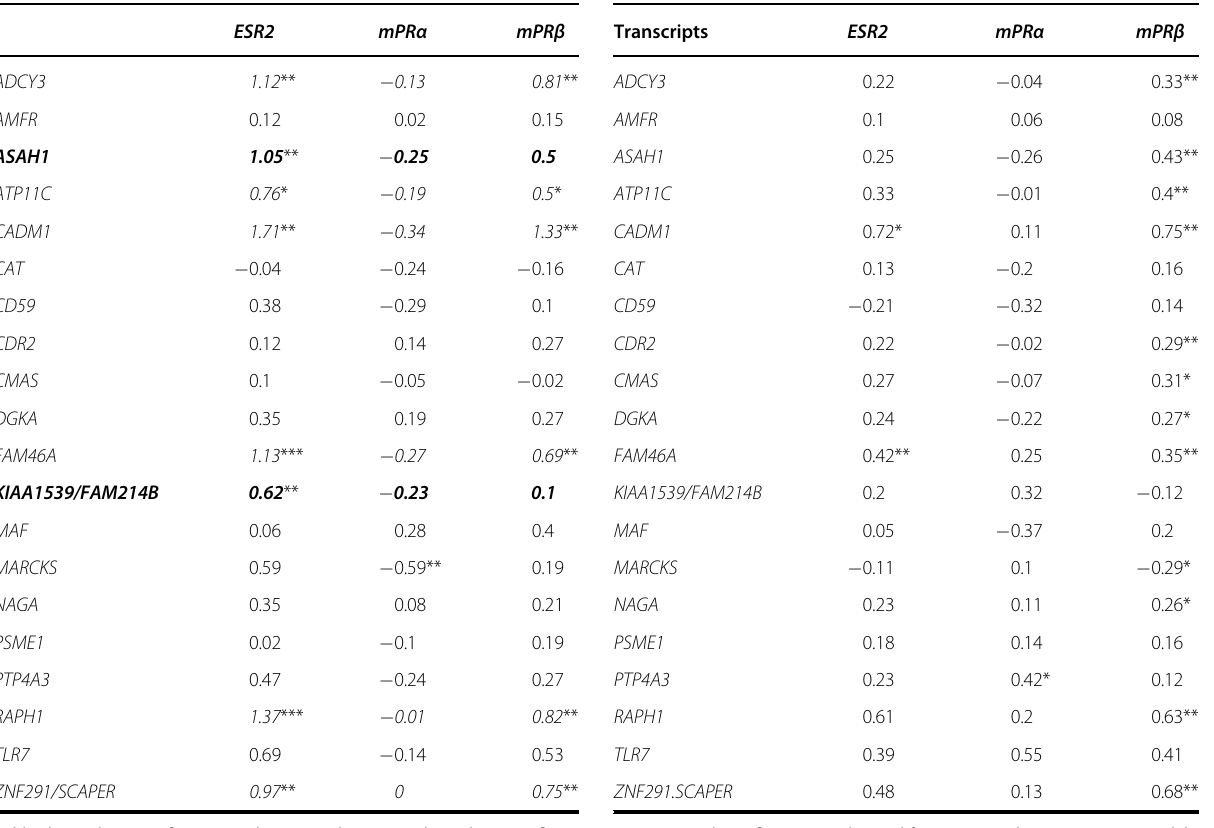
Table 6 Linear regression models to evaluate association between biomarker transcript levels and expression of